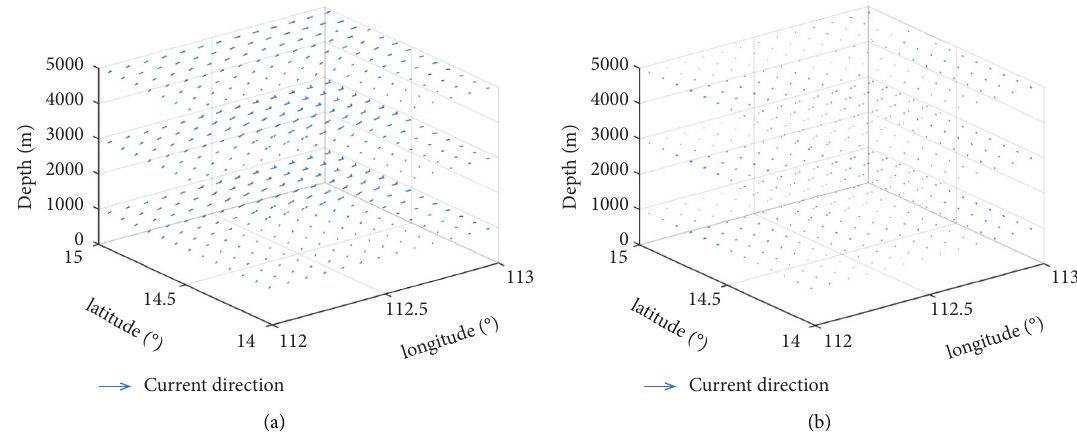
Figure 4: Time-varying fields compendious distribution in 112 ° E − 113 ° E and 14 ° N 15 °